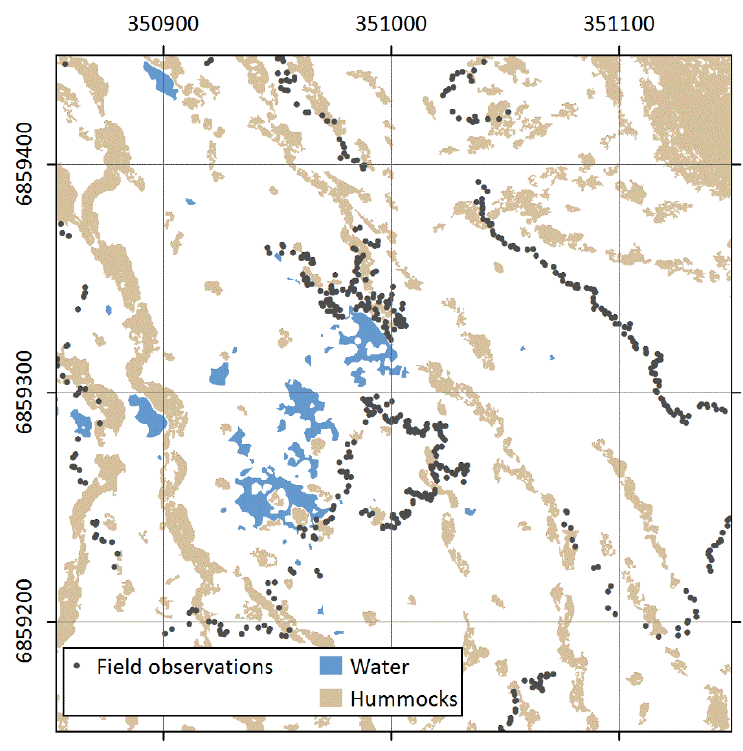
Figure 6. Map of the 756 vegetation plots of